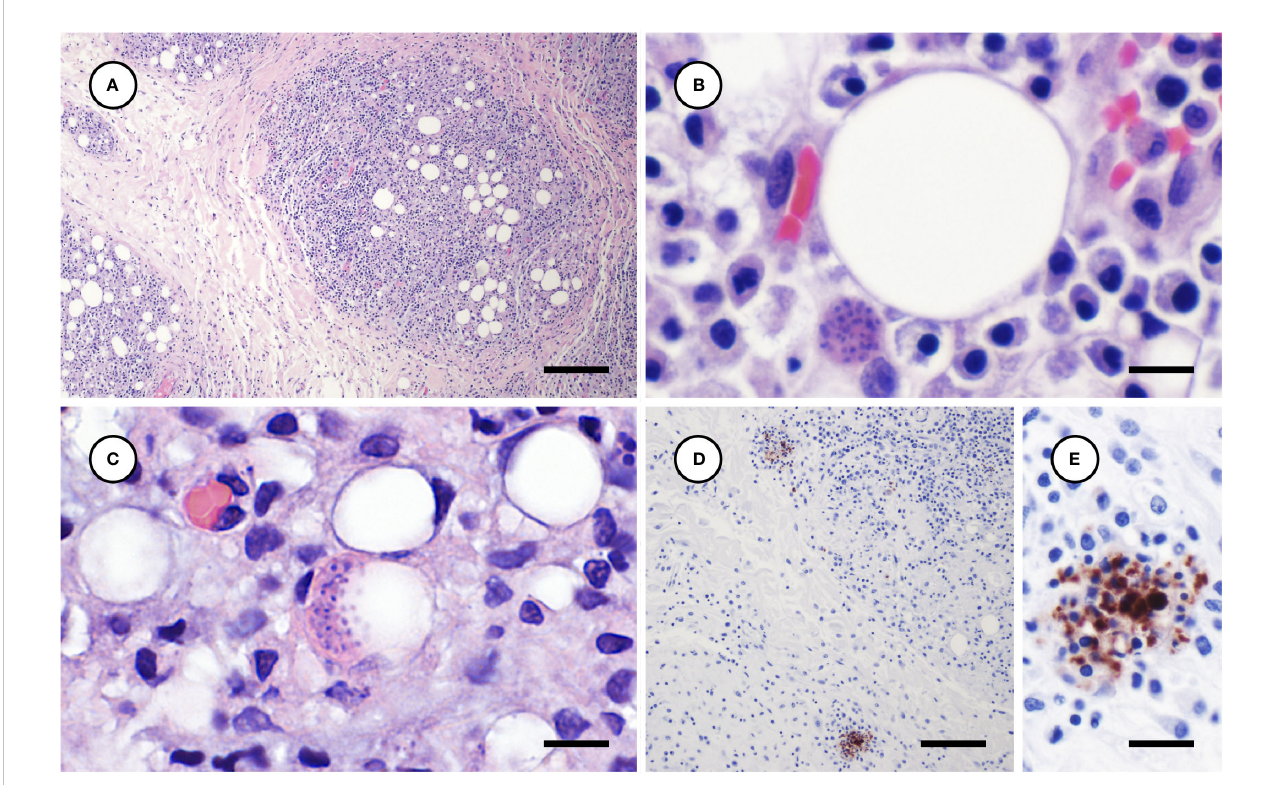
FIGURE 7 Histological and immunohistochemical appearance of subcutaneous and peritoneal steatitis from sea otters with fatal protozoal steatitis and toxoplasmosis. (A – C) : Progressively higher magni fi cation views of severely in fl amed adipose tissue (A) ; a Toxoplasma gondii -like protozoal tissue cyst is located adjacent to a large lipid vacuole (B) and numerous parasites are clustered along the periphery of a cytoplasmic lipid vacuole (C) (H&E stain, bar = 200, 10, and 10 µm, respectively). Immunohistochemical stains of in fl amed peritoneal adipose, demonstrating strong positive T. gondii immunostaining of intralesional protozoa at lower (D) and higher (E) magni fi cation ( D , E : bar = 100 and 20 µm,